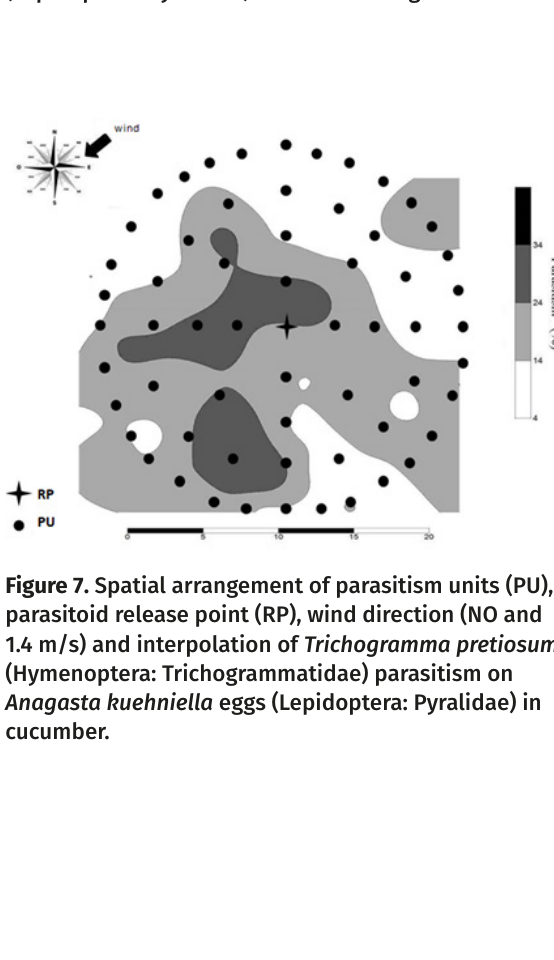
Figure 6. Spatial arrangement of parasitism units (PU), parasitoid release point (RP), wind direction (NO and 1.2 m / s) and interpolation of Trichogramma pretiosum (Hymenoptera: Trichogrammatidae) parasitism on eggs of Anagasta kuehniella (Lepidoptera: Pyralidae) in maize V8 stage.